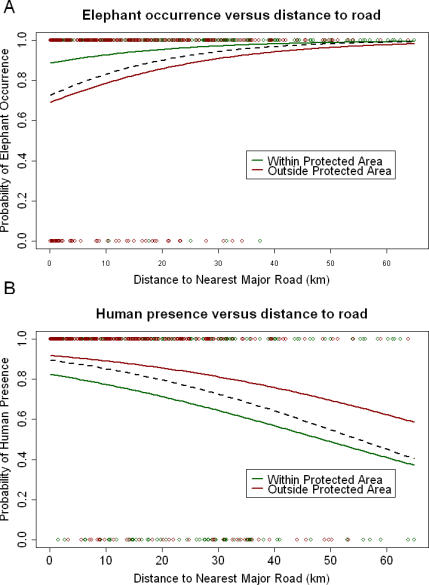
Results of Fitting a Logistic Regression Model to Elephant and Human Presence/Absence Megatransect DataDistance to road (in kilometres) and location within or outside the protected areas were used as explanatory variables. (A) shows the elephant data, and (B) shows the human data. The observations and regression lines are colour-coded to correspond to within or outside the protected areas and the dashed line shows the regression line with only the distance to road covariate. The covariates distance to road and location within or outside the protected areas are significant for both elephant and human probability of occurrence.